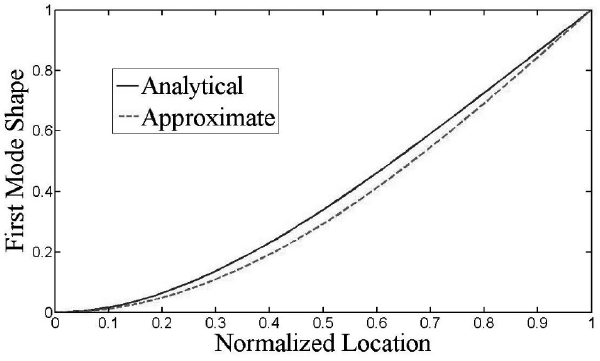
Fig. 2. The analytical ( −−− ) and the approximate ( − − − ) fi rst mode shape of the cantilever